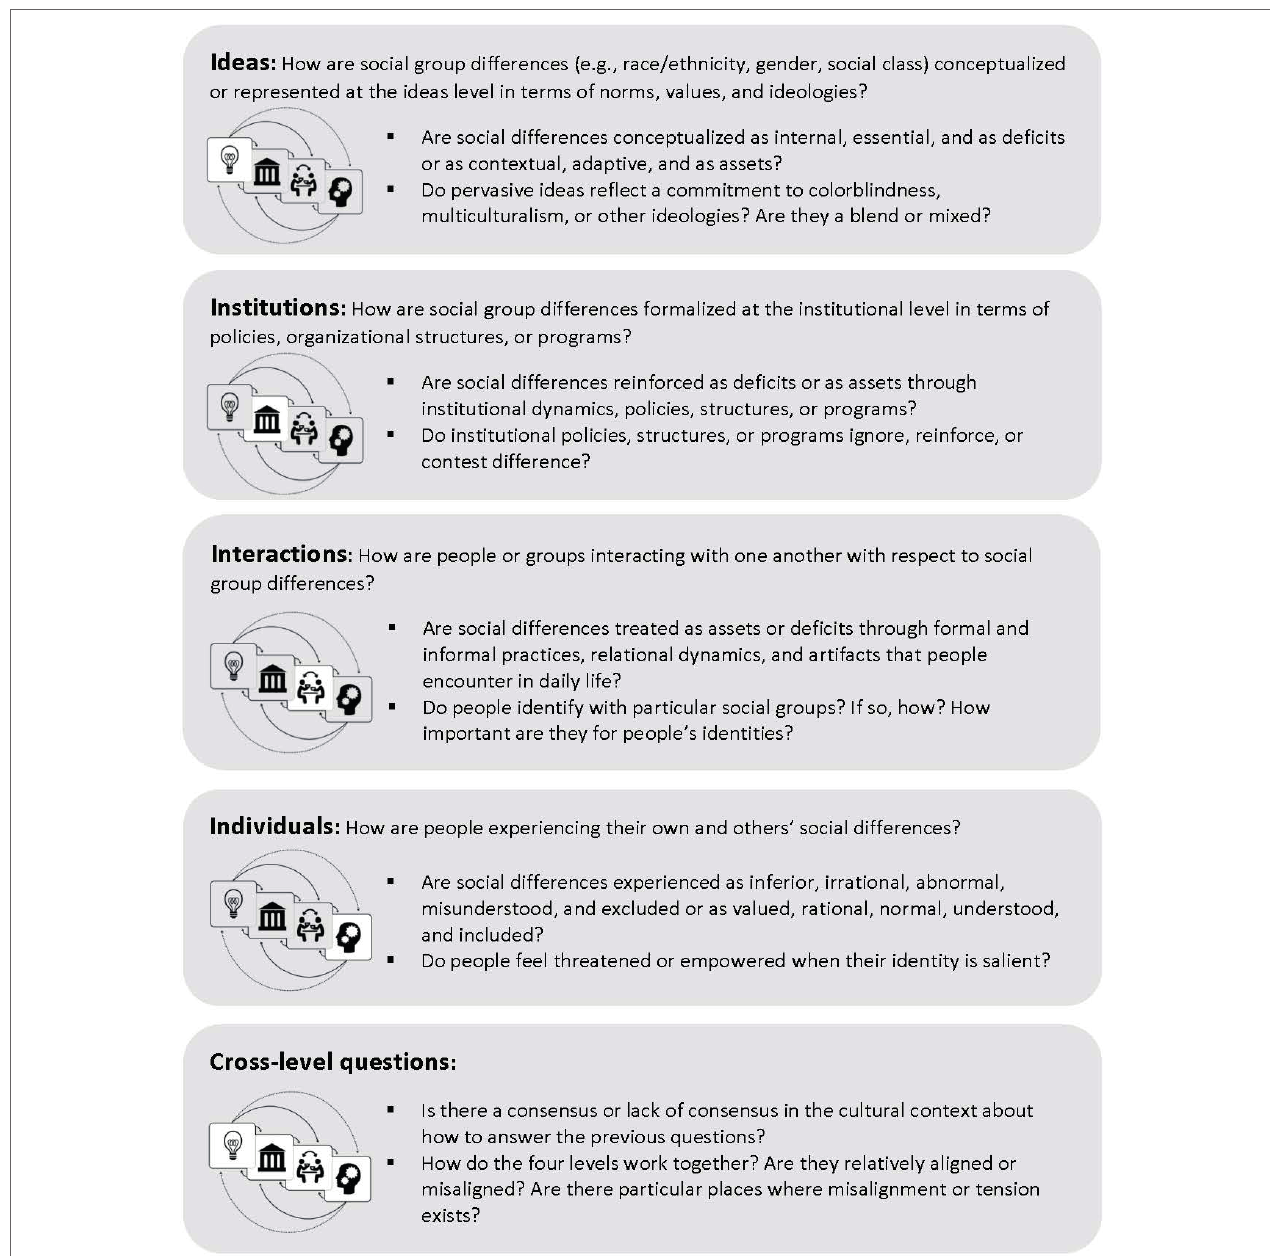
FIGURE 2 | Using the culture cycle to understand culture clashes and catalyze change: Mapping social group differences. Adapted from Markus and Hamedani